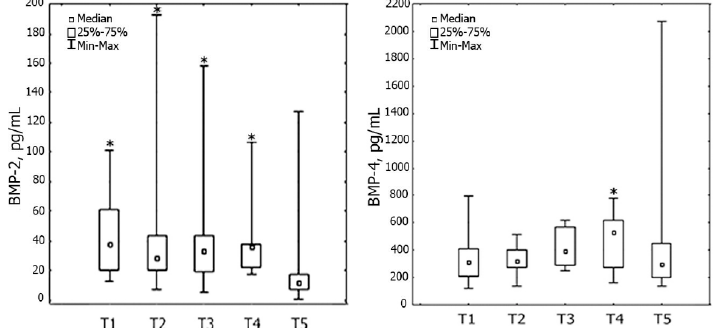
Figure 2. Dynamics of serum levels of BMP-2 and BMP-4 ( n = 31) in the six-month period in patients STEMI. Note: * p < 0.05: significant di ff erence between time point T5 and other time points. BMP—bone with STEMI. Note:* p < 0.05: significant difference between time point T5 and other time points. morphogenetic protein; T1—1st day; T2—3rd day; T3—7th day; T4—14th day; T5—6months after BMP—bone morphogenetic protein; T1—1st day; T2—3rd day; T3—7th day; T4—14th day; T5—